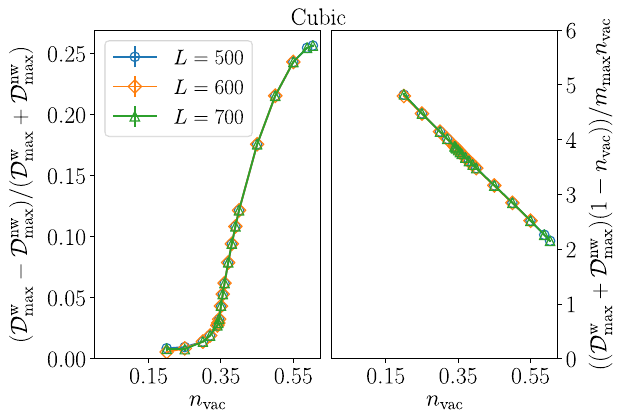
the thermodynamic limit in d ¼ 3 dimensions on the cubic lattice. symmetry breaking transition (Sec. VII C). From the sample average of the corresponding ratio, I modes hosted by the On the cubic lattice, the corresponding proportionality constant decreases rapidly in the low-dilution limit.